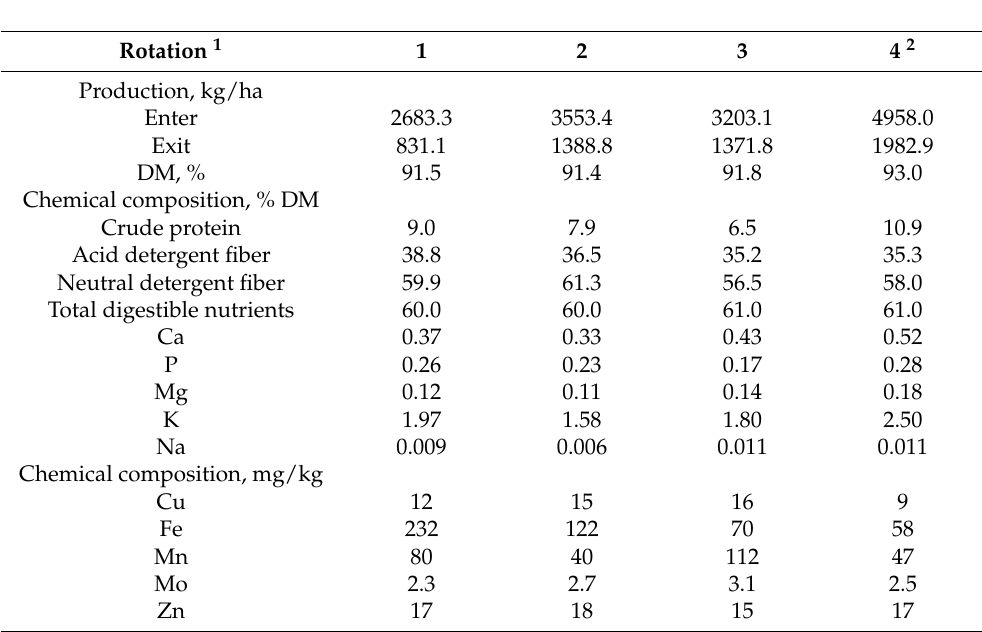
Table 3. Cow pastures (1–4) forage quality and production at the time of entry and exit at the Montana State University Fort Ellis research